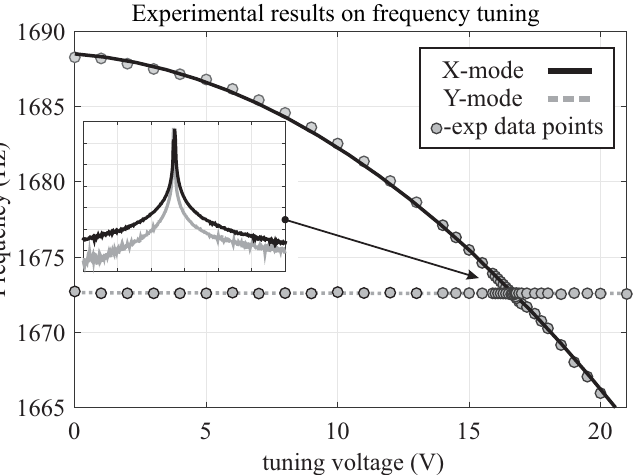
Figure 7. Experimentally obtained frequency response of the QMG showing the frequency separa- tion changes between the orthogonal axes by applying DC bias to the X-mode pickoff electrodes. Illustrating the X-mode resonance frequency decreases with increase tuning voltage while Y-mode resonance frequency keeps